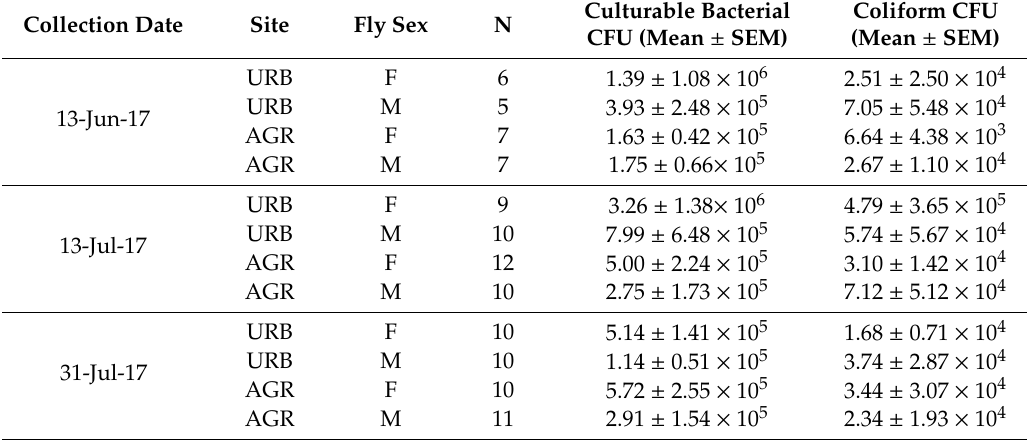
Table 1. Abundance of culturable bacteria and coliforms in house flies collected from urban and agricultural